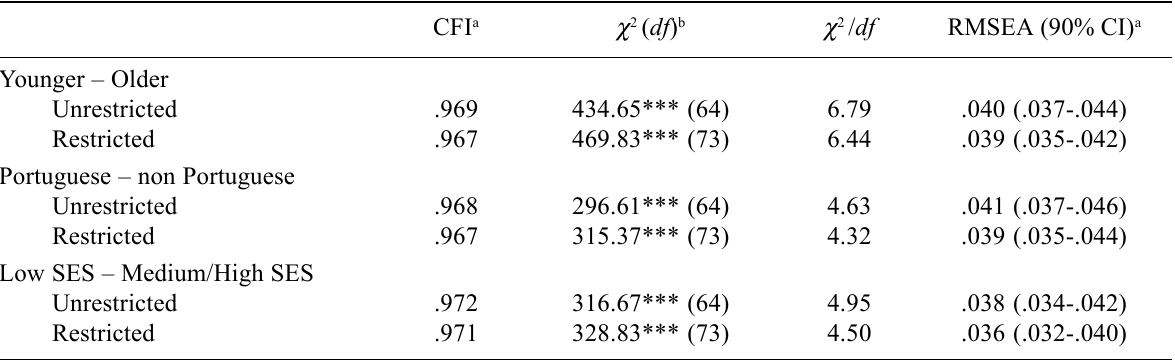
Factorial Invariance with Fit Statistics for Unconstrained and Constrained